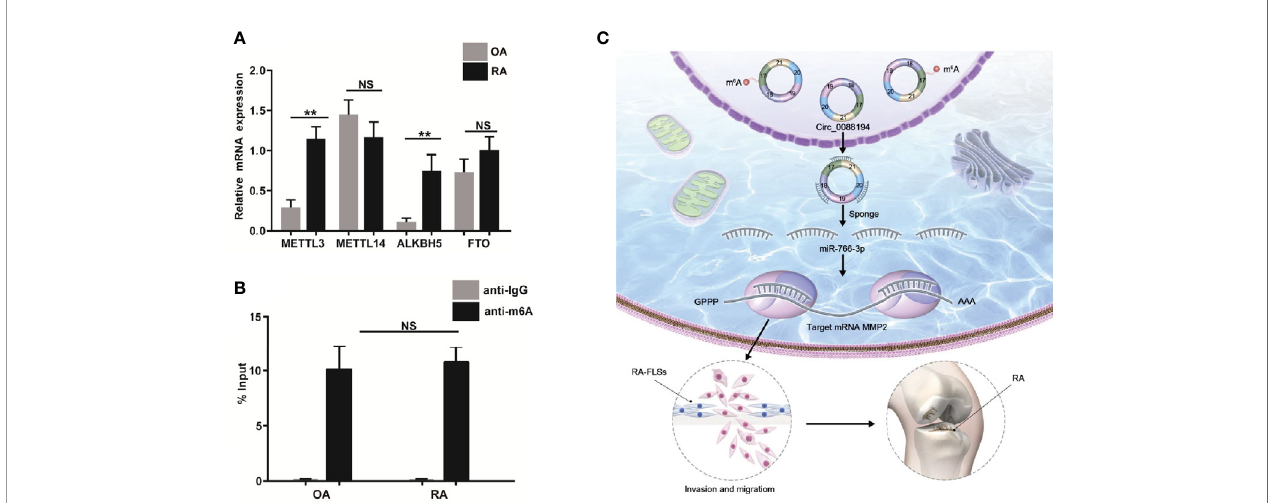
FIGURE 7 | Circ_0088194 m 6 A modi fi cation in RA-FLSs. (A) QRT-PCR determined the mRNA level of four components of the m 6 A methylase complex methyltransferase-like 3 (METTL3), alkB homolog 5 (ALKBH5), methyltransferase-like 14 (METTL14), and fat mass and obesity associated genes (FTO) in RA-FLSs and OA-FLSs. (B) Anti-m 6 A antibody-enriched m 6 A-modi fi ed total RNA immunoprecipitation followed by qRT-PCR determined the m 6 A-modi fi ed Circ_0088194 levels in RA-FLSs and OA-FLSs. The negative control for immunoprecipitation comprised rabbit IgG. The percentages of input are shown. (C) A working model of the Circ_0088194/miR-766-3p/MMP2 signaling axis in the promotion of the migration and invasion of RA-FLSs and RA pathogenesis. Data are shown as mean ± SD. NS: not signi fi cant. **indicates p <